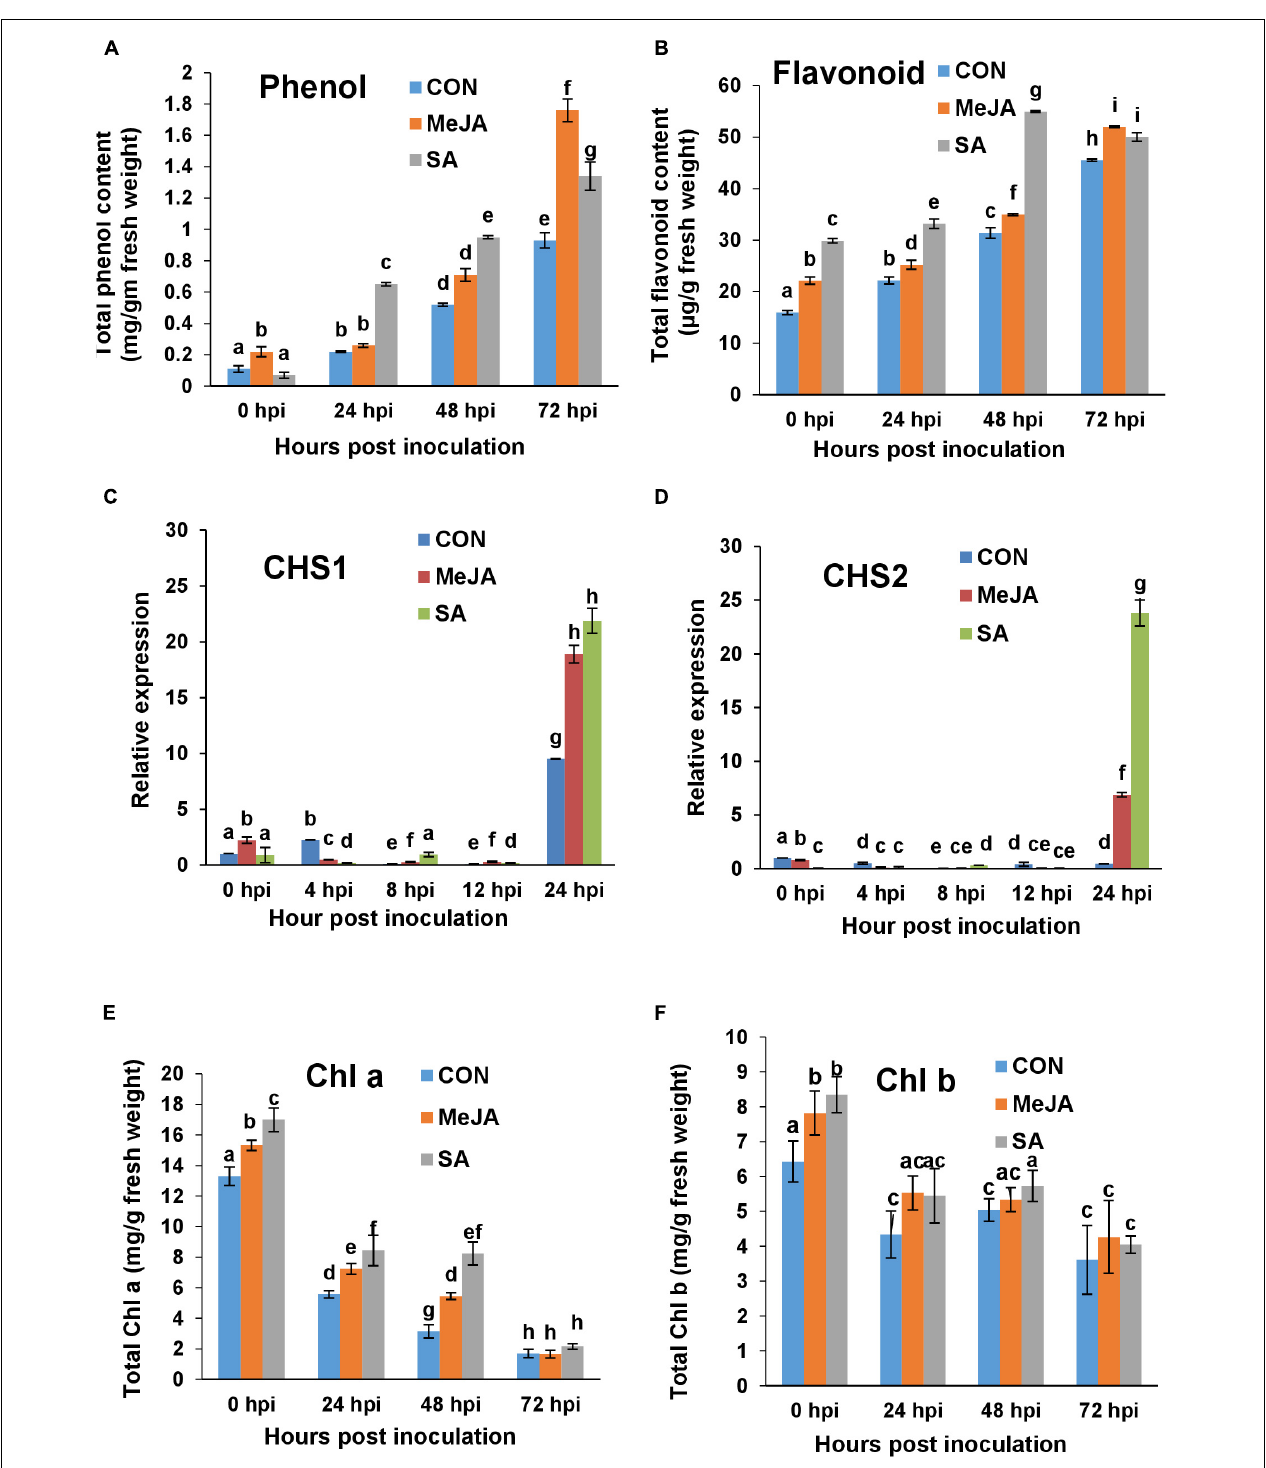
FIGURE 12 | Comparison of accumulation of polyphenolics, induction of their genes, and chlorophyll content in the control and phytohormone primed plants during R. solani pathogenesis. (A) Total phenol content in different sets over a time course. (B) Total flavonoid content. (C,D) Quantitative real-time PCR analysis of the expression of Chalcone synthase genes CHS1 and CHS2 respectively over a time course. (E,F) Chlorophyll a (Chl a) and Chlorophyll b ( Chl b) content respectively showing least degradation after infection in SA-primed leaves compared to Control and JA-primed leaves. Bars represent mean ± SEM of three independent experiments with at least three individual plants. Different letters indicate significant differences among treatments at p < 0.05, according to Duncan’s multiple range test.